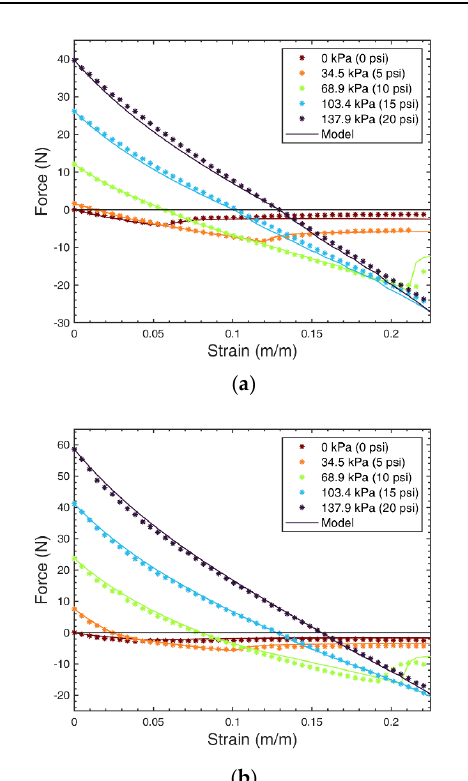
Figure 12. Result of empirical-based tuning of parameters and comparison to experimental data for a FAM with ( a ) slenderness ratio of 8 and ( b ) slenderness ratio of 10. Forces for 0, 34.5, 68.9, 103.4, and 137.9 kPa are measured and used to optimize the parameters specified in Table 1. The Young’s modulus, collapse moment, and transition rate constant are independent of pressure, while the torsional spring stiffness varies with